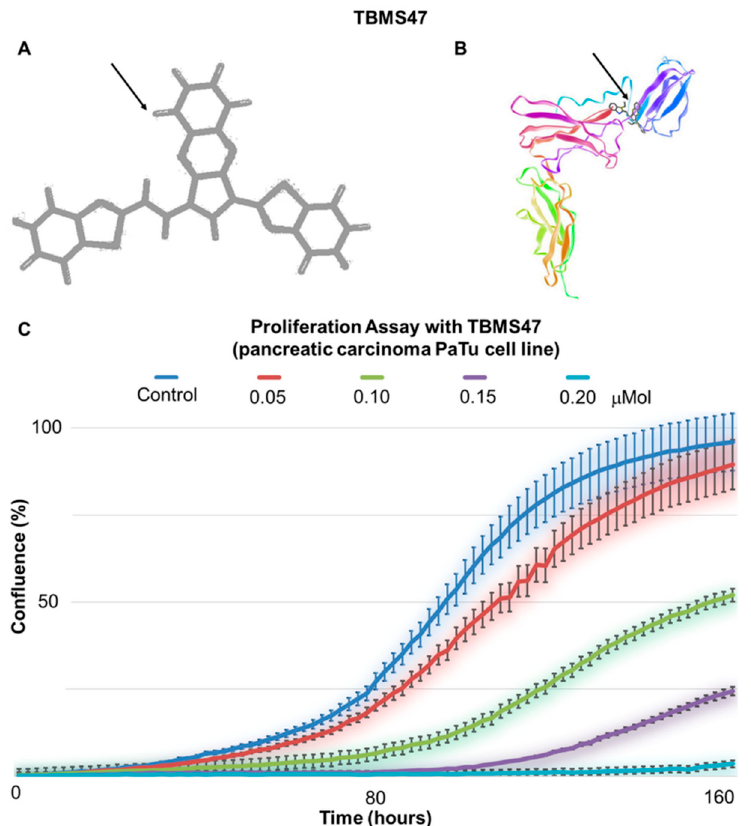
Figure 10. Inhibitor TBMS47 ( A —structure, B —model). Chemical structure of experimental substance TBMS47 (arrow) was designed to interact with IL-6R and its docking to the binding site of IL-6R recognizing IL-6. ( C ) TBMS47 inhibits in vitro proliferation of PaTu cells from pancreatic adenocarcinoma (represented here as Confluence %) in a concentration-dependent manner measured using Incucyte instrumentation (each line represents six technical replicates; error bars represent standard deviation of six wells).